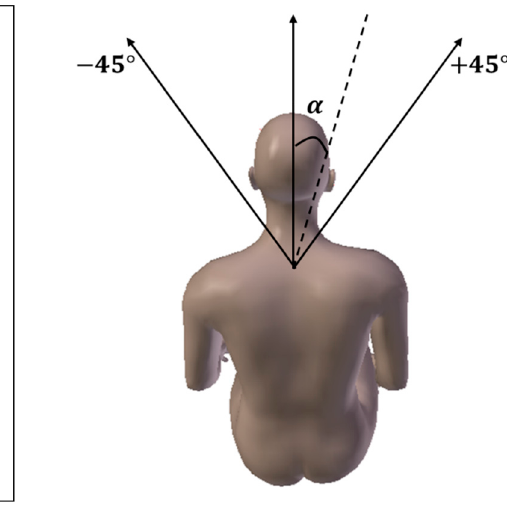
Figure 4. Illustration of a node traveling pattern using RW mobility model.